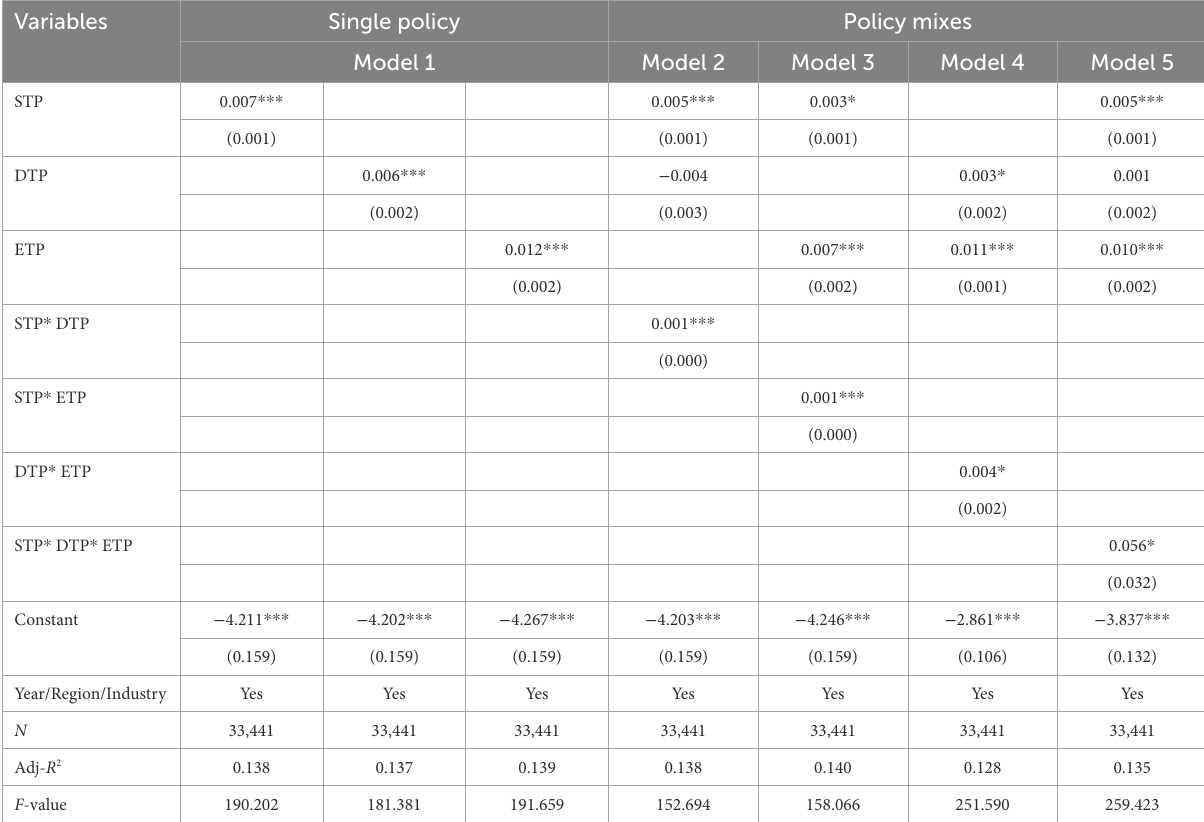
TABLE 9 Estimation for substituting the dependent variables.